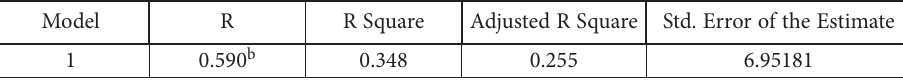
Table 2. Summary of the Regression Model